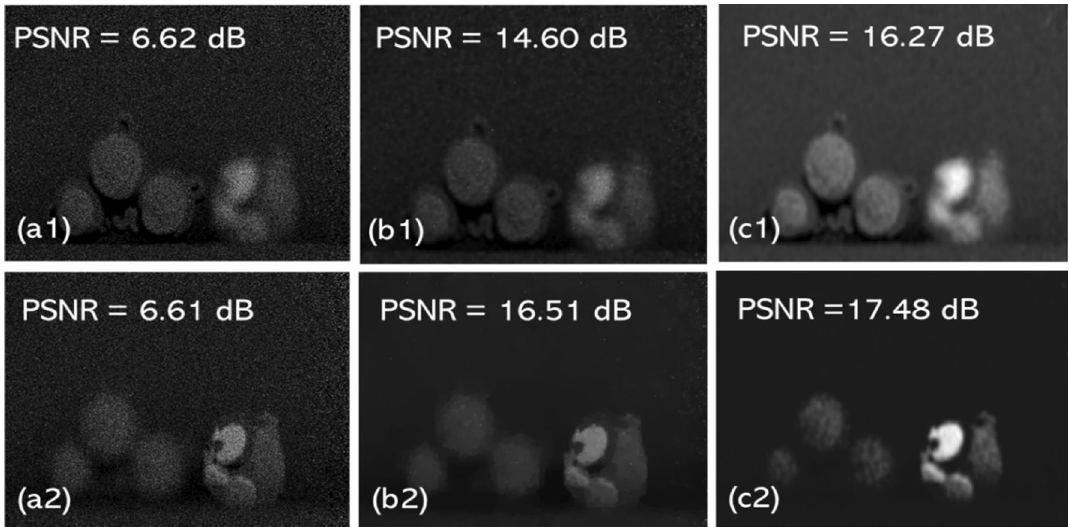
Figure 4. Denoised results: ( a1 , b1 , c1 ) represents noisy Photon counted 3D sectional image, TV denoised image and result of our proposed denoising method when object 1 is in focus, respectively and ( a2 , b2 , c2 ) represents the noisy Photon counted 3D sectional image, TV denoised image and result of our proposed denoising method when object 2 is in focus,